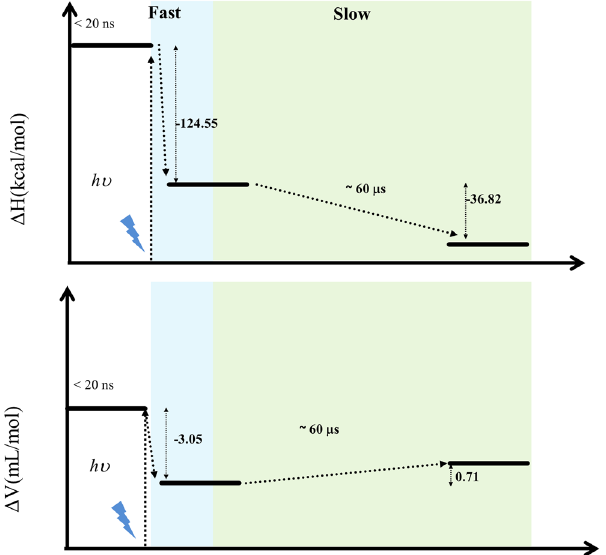
Figure 6. Refolding reaction coordinate of the partially misfolded V5C-DMC after